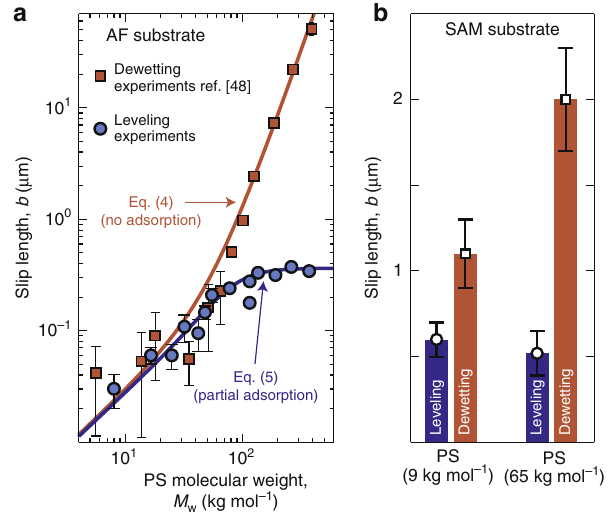
Fig. 3b. As for AF/PS, both molecular weights show a discrepancy between the slip length accessed with leveling and dewetting.